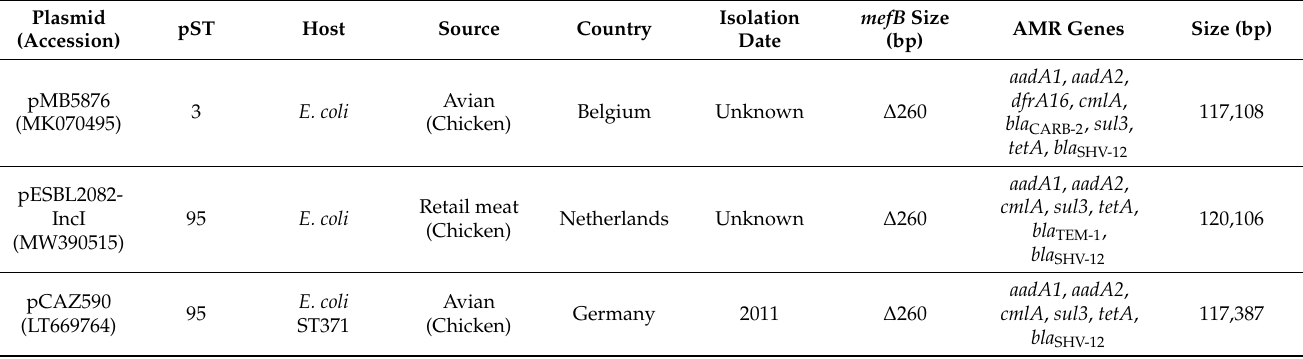
Table 1. Details of sul3 -encoding I1 plasmids.